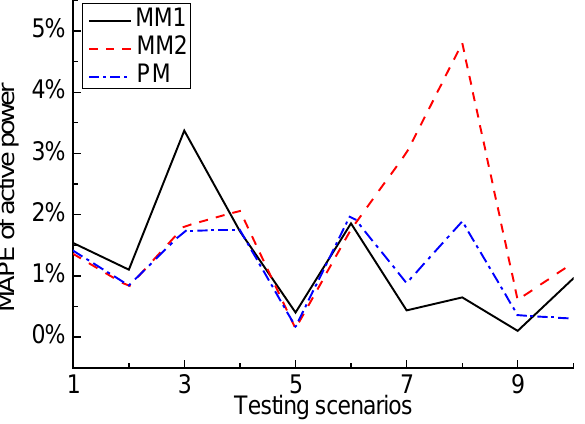
Figure 7. Active power errors of different models in quasi-steady-state process during fault duration.